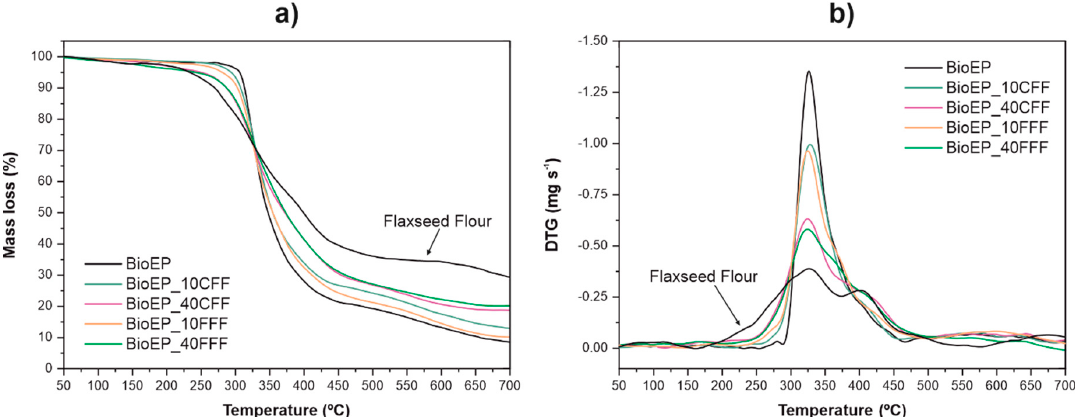
Figure 4. Thermal degradation of BioEP, FF, and BioEP/FF composites reinforced with a different content of coarse (CFF) and fine (FFF) flaxseed flour ( a ) thermogravimetry (TG) weight loss and ( b ) differential thermogravimetry (DTG) first derivative curves.